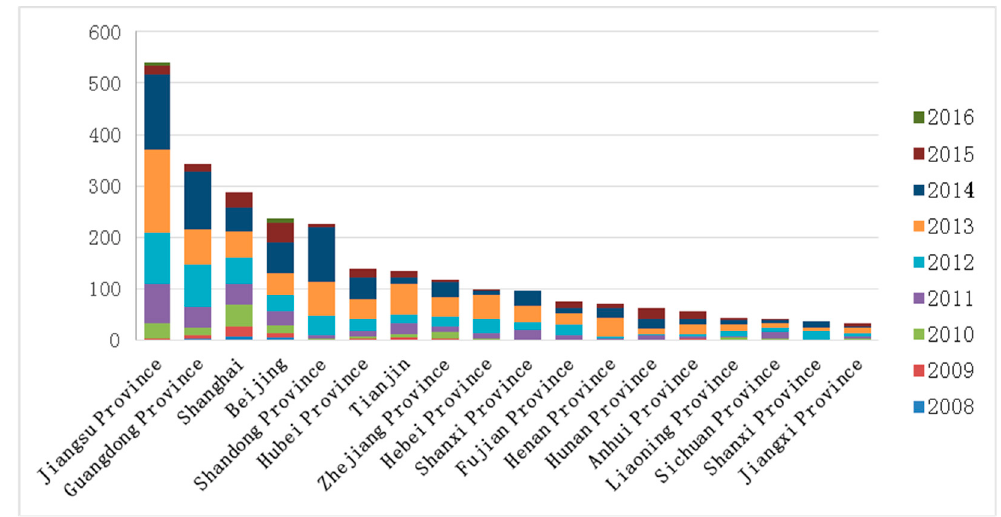
Figure 4. Provinces and cities at the forefront of green building projects in China.